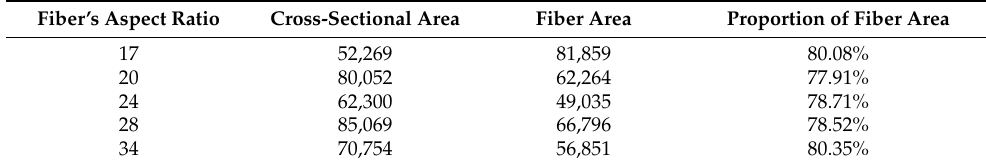
Figure 11. A series of cross section images used to analyze fiber area percentage at the optimum amount of fiber by Image Pro Plus image processing software (Image Pro Plus 6.0, Media Cybernetics, Bethesda, MD, USA). Table 4. The statistical fiber area proportion of the optimum fiber number for each fiber’s aspect